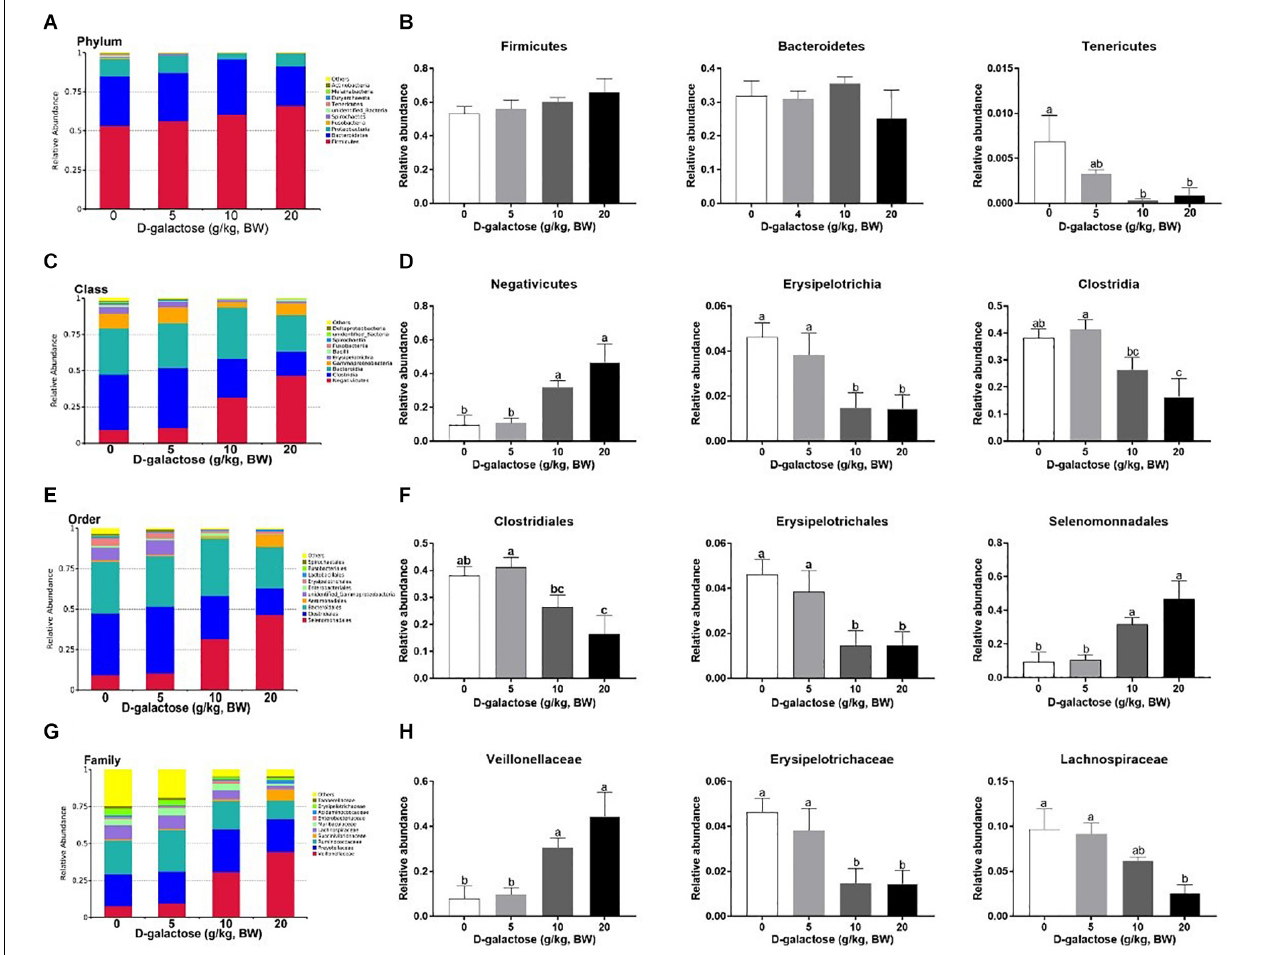
FIGURE 13 | Effects of D -galactose on colonic macterial composition at the phylum, class, order, and family levels. (A,B) Phylum level; (C,D) Class level; (E,F) Order level; (G,H) Family level. Data were expressed as the mean ± SEN. Different lower-case letters indicate a significant difference among different dosage of D -galactose ( P <